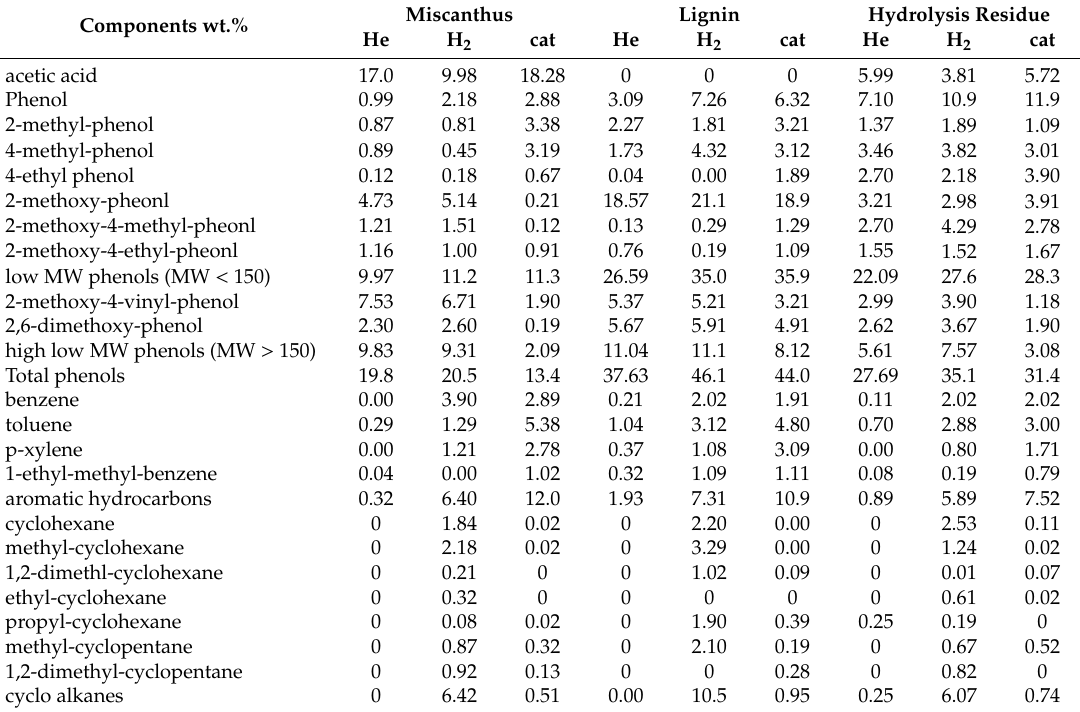
Table 3. Peak area percentages for the acetic acid, phenols, aromatics hydrocarbons and cyclo-alkanes (the accuracy was in a range of